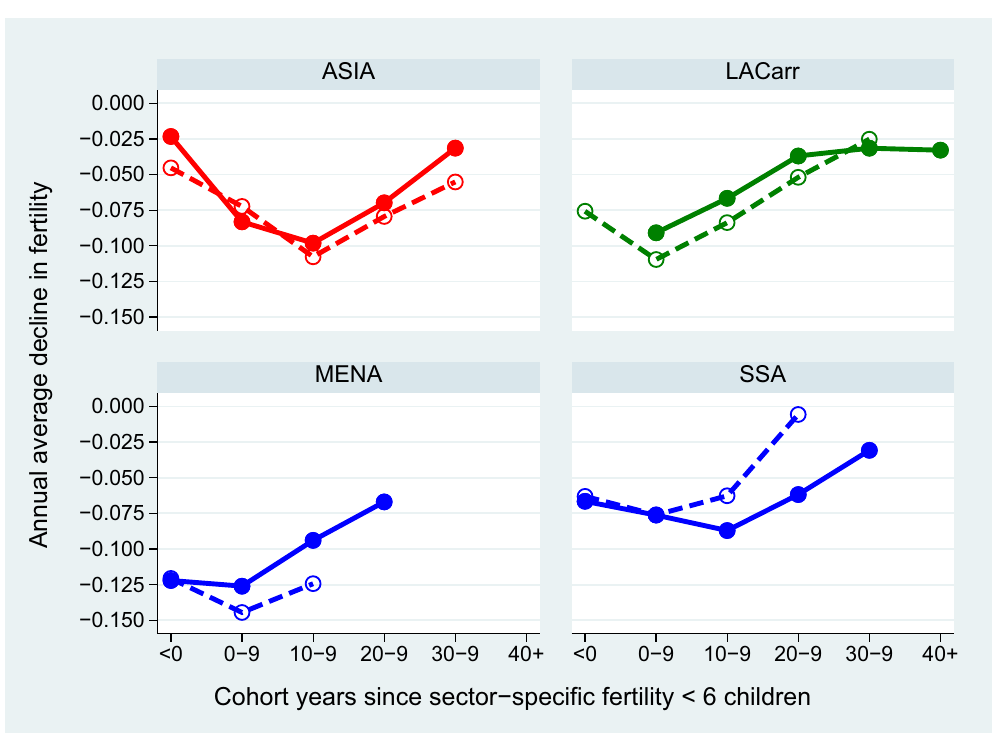
Fig 4. Regional averages of the annual pace of cohort fertility decline in urban and rural areas (full and dashed line, respectively) over the course of the national and sector-specific fertility transitions, cohorts 1896–1982 in 50 African, Asian and Latin American countries. Source: WFS & DHS, MICS, IPUMS. Notes: full lines indicate the urban pace, dashed lines indicate the rural pace; LACarr = Latin America and the Caribbean, MENA = Middle East and Northern Africa, SSA = sub-Saharan Africa; the onset of the sector-specific transition corresponds to the first cohort with total fertility below 6 children per woman.